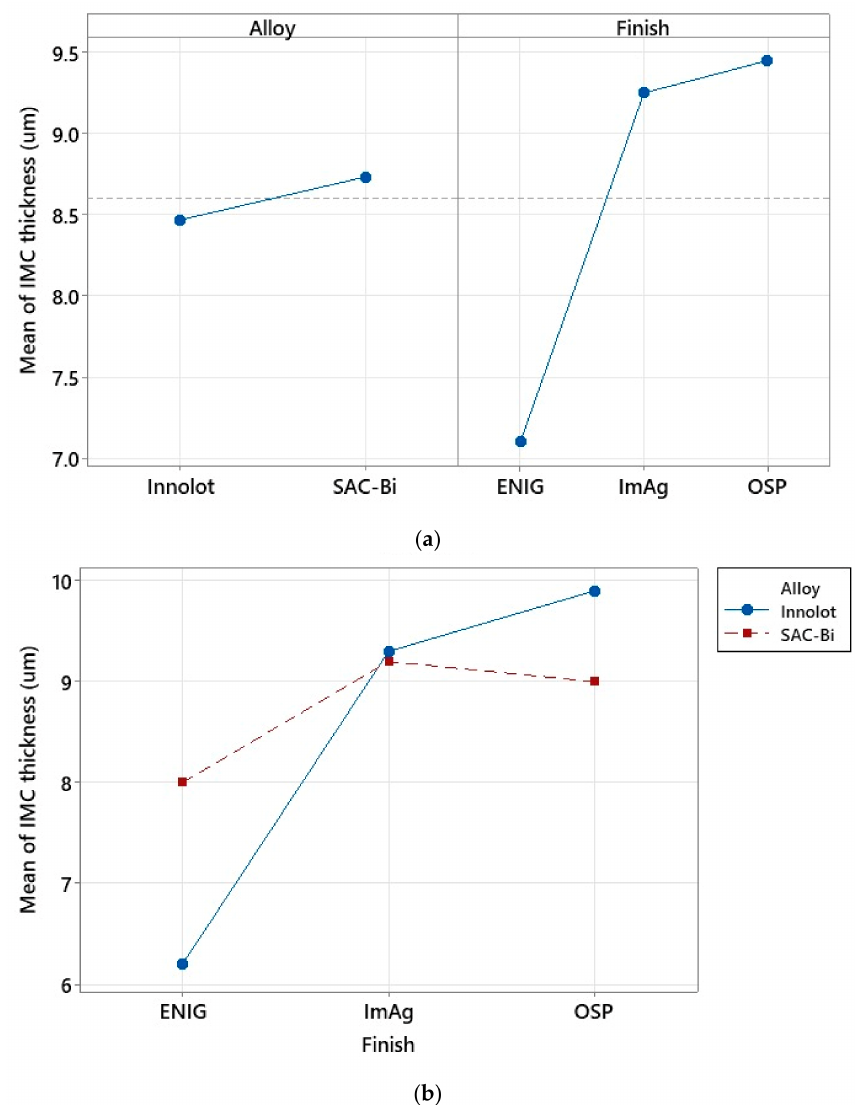
Figure 9. ANOVA analysis for IMC growth; ( a ) Main effects plot; and ( b ) Interaction